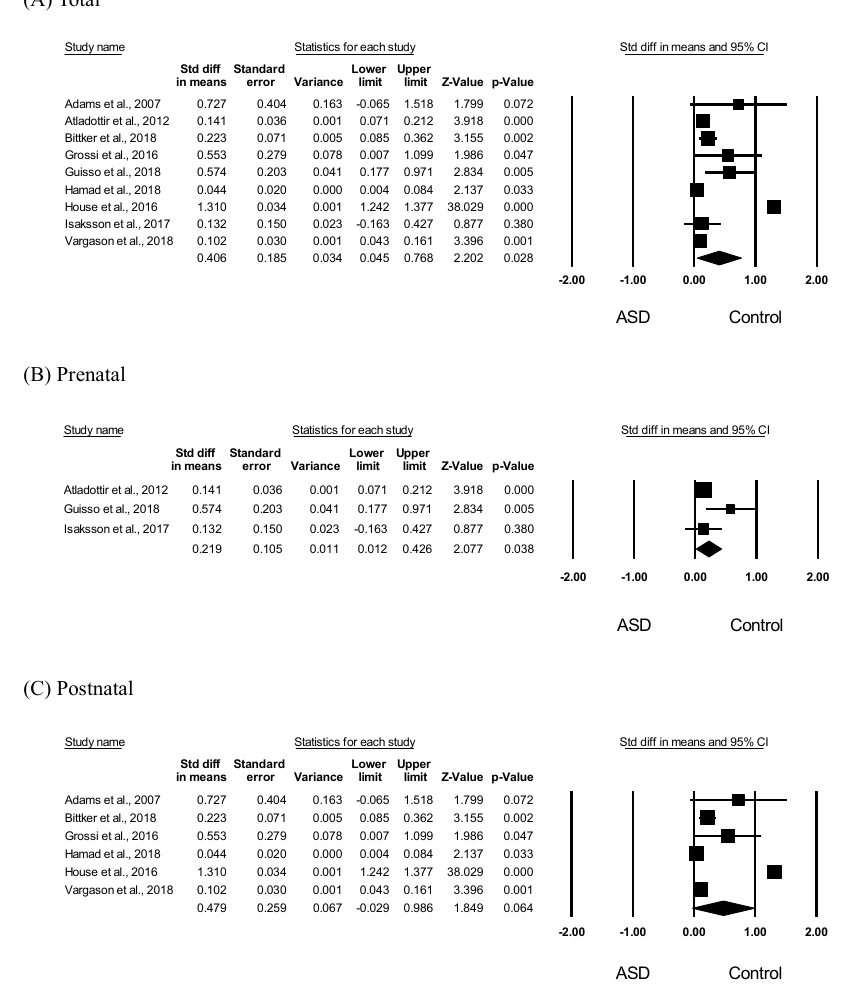
Figure 3. Meta-analysis of early antibiotic exposure in children with ASD. E ff ects sizes were measured as standardized mean difference in the ASD group compared to that in the control group. ( A )